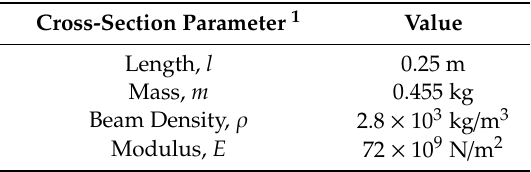
Figure 2. Schematic of flexible robotic arm in Figure 1. Flexible space robot arm nodes (corresponding to Table 2) are numbered from the base of the arm beginning with node 1 (i.e., nodes 2, 3, 4 and 5 displace by rotation upward and downward, while nodes 5, 6, 7 and 8 displace translationally left and right). Table 1. Properties of flexible spacecraft simulator (FSS).